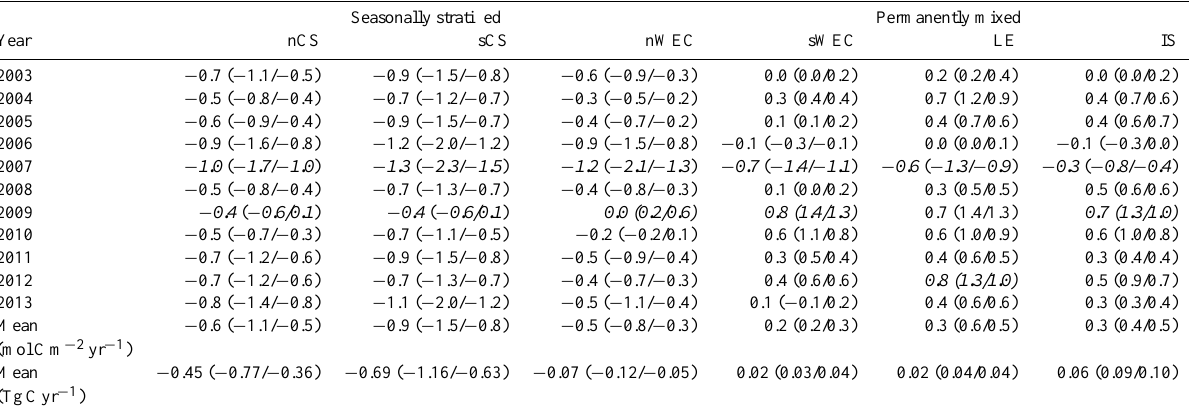
Table 4. Annual air–sea CO 2 fluxes (in molCm − 2 yr − 1 ) in the seasonally stratified (nCS, sCS and nWEC) and permanently mixed provinces (sWEC, LE and IS) of our study area between 2003 and 2013 and the mean annual fluxes over the decade using Nightingale et al. (2000) k parameterization. Scaled annual fluxes over province areas (Table 2) inTgCyr − 1 were calculated from the mean annual fluxes over the decade. Fluxes in brackets were calculated using Wanninkhof et al. (1992) and Wanninkhof and McGillis (1999) k parameterizations. Values in italic correspond to the minimal and maximal air–sea CO 2 flux values computed in each